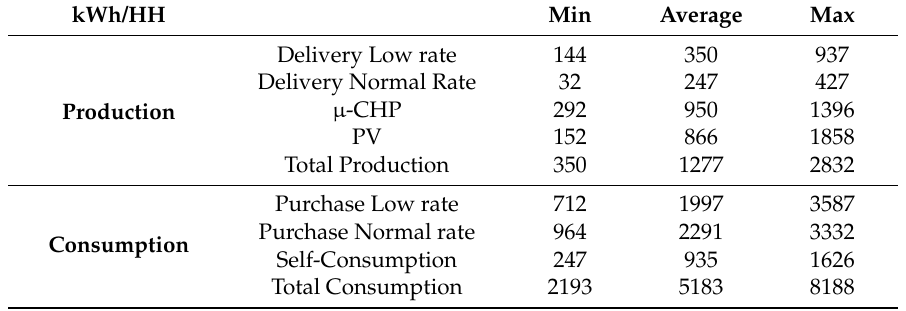
Figure 2. PowerMatching City electricity purchase, self-consumption, and production in 2012: ( a ) Electricity generated by PV and μCHP; percentages of self -consumption and electricity delivery depending rates; ( b ) Self consumption and electricity purchased from the grid, with purchase percentages depending on rates. Table 4. Minimum, average, and maximum values for the PMC Households for the year 2012.